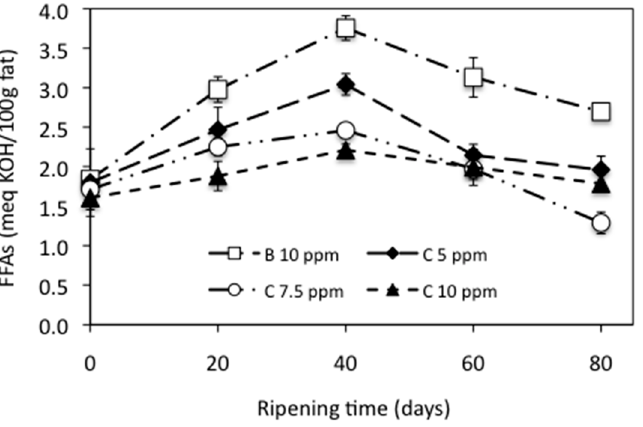
Figure 2. Lipolysis of manchego-style cheeses ripened at 10 °C, expressed as free fatty acids (FFAs) content. B = bixin, C = curcumin.